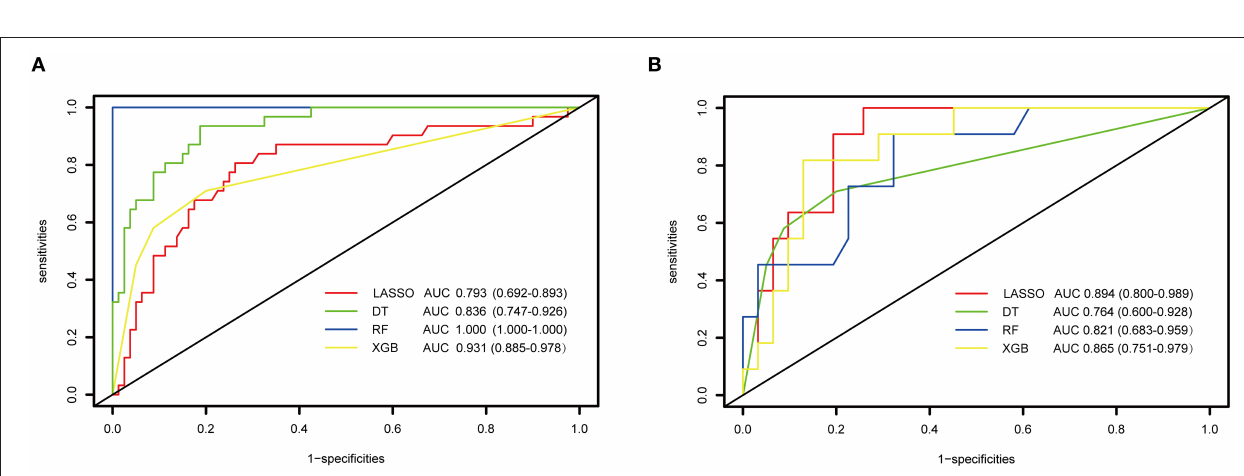
CI : 0.751–0.979, p = 0.69). Figure 3 shows the performance